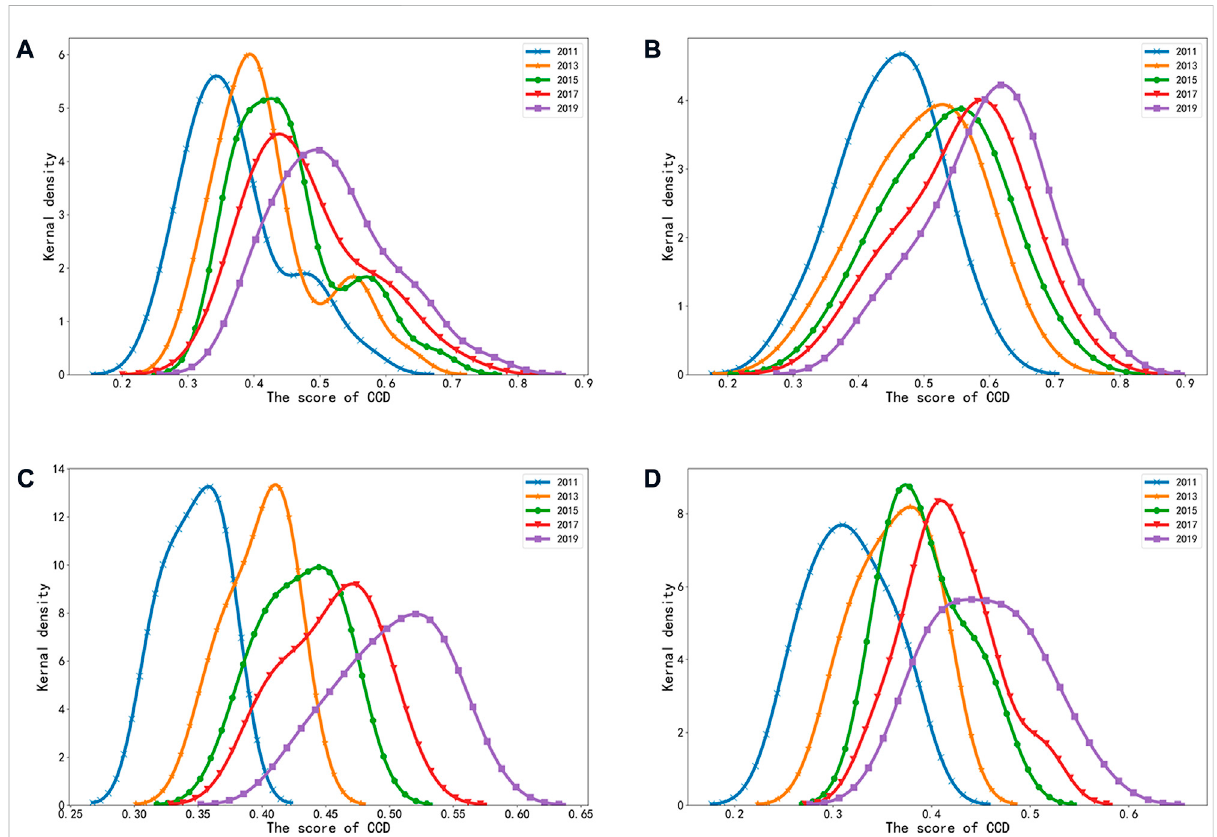
FIGURE 3 CCDkerneldensityofnationalandregional. (A) KerneldensityofChina; (B) KernelDensityofeasternregion; (C) KernelDensityofcentralregion; (D) Kernel Density of western